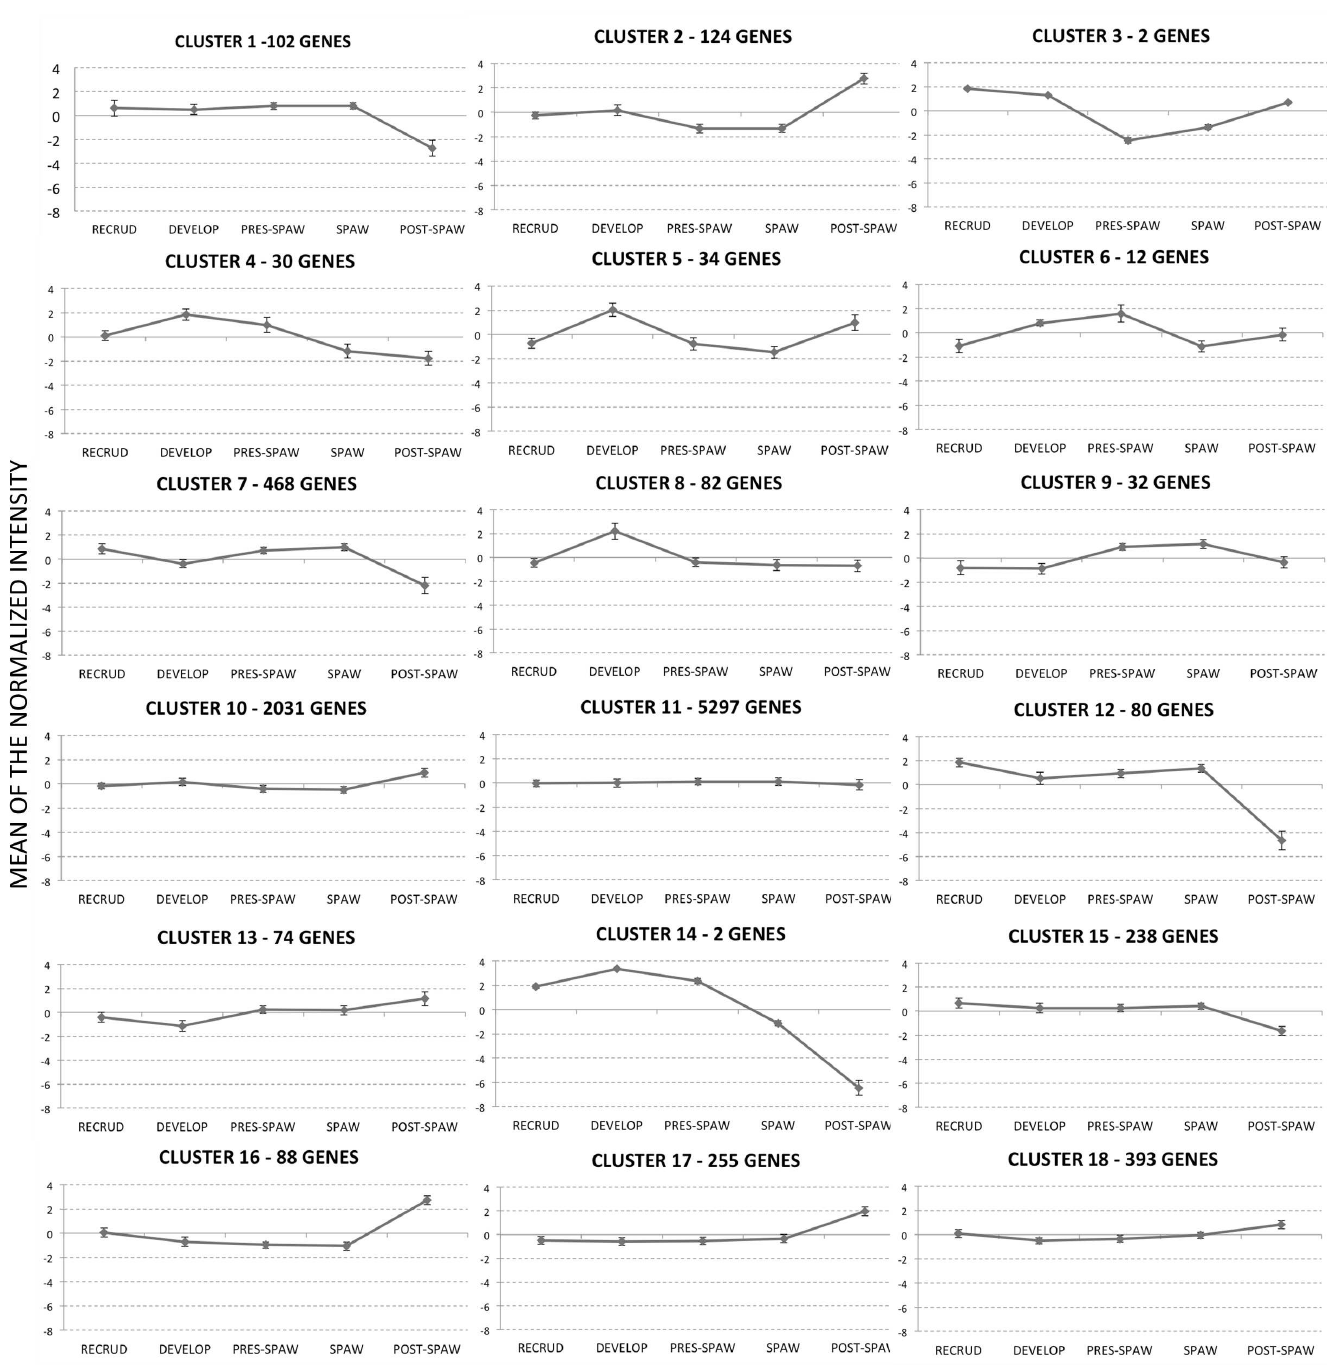
Fig 7. Gene expression patterns based upon k-means clustering. Data were used for the computation of expressiontrends in the set of 9,344 genesin male gonadsacross the annualcycle. K-means is an iterative procedureaimed to reducethe varianceto a minimum within each cluster. A total of 18 different patterns of gene expressionwere determined. The tendencycurve (centroid)is depictedby the solid line with the SE of the